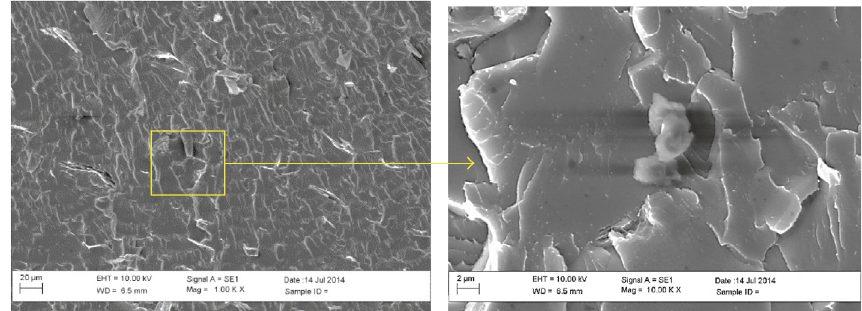
Figure 5: SEM images at low and high magnifications of fracture surfaces of PET-GNP nanocomposites containing 2 wt.% of GNP.